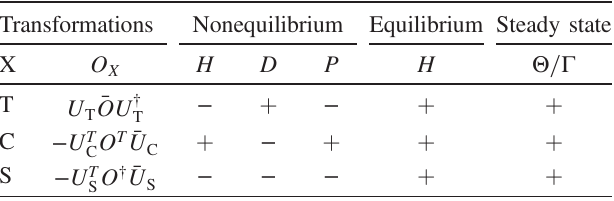
TABLE II. Transformation of the (individually Hermitian or anti-Hermitian) matrix operators O ¼ H; D; P; Γ ; Θ entering the evolution of the covariance matrix under the fundamental symmetries, T, C, S. The sign factors indicate whether O ¼ (cid:3) O X under the transformation. Out of equilibrium, they are chosen to leave the Lindblad equation invariant. In equilibrium [cf. Sec. V, including for the transformation laws of the equilibrium analogs of D , P , Eqs. (46) and (48)], the indicated transformation of the Hamiltonian leaves the equilibrium Kel- dysh action invariant. In either case, the Gaussian stationary states transform as indicated in the last